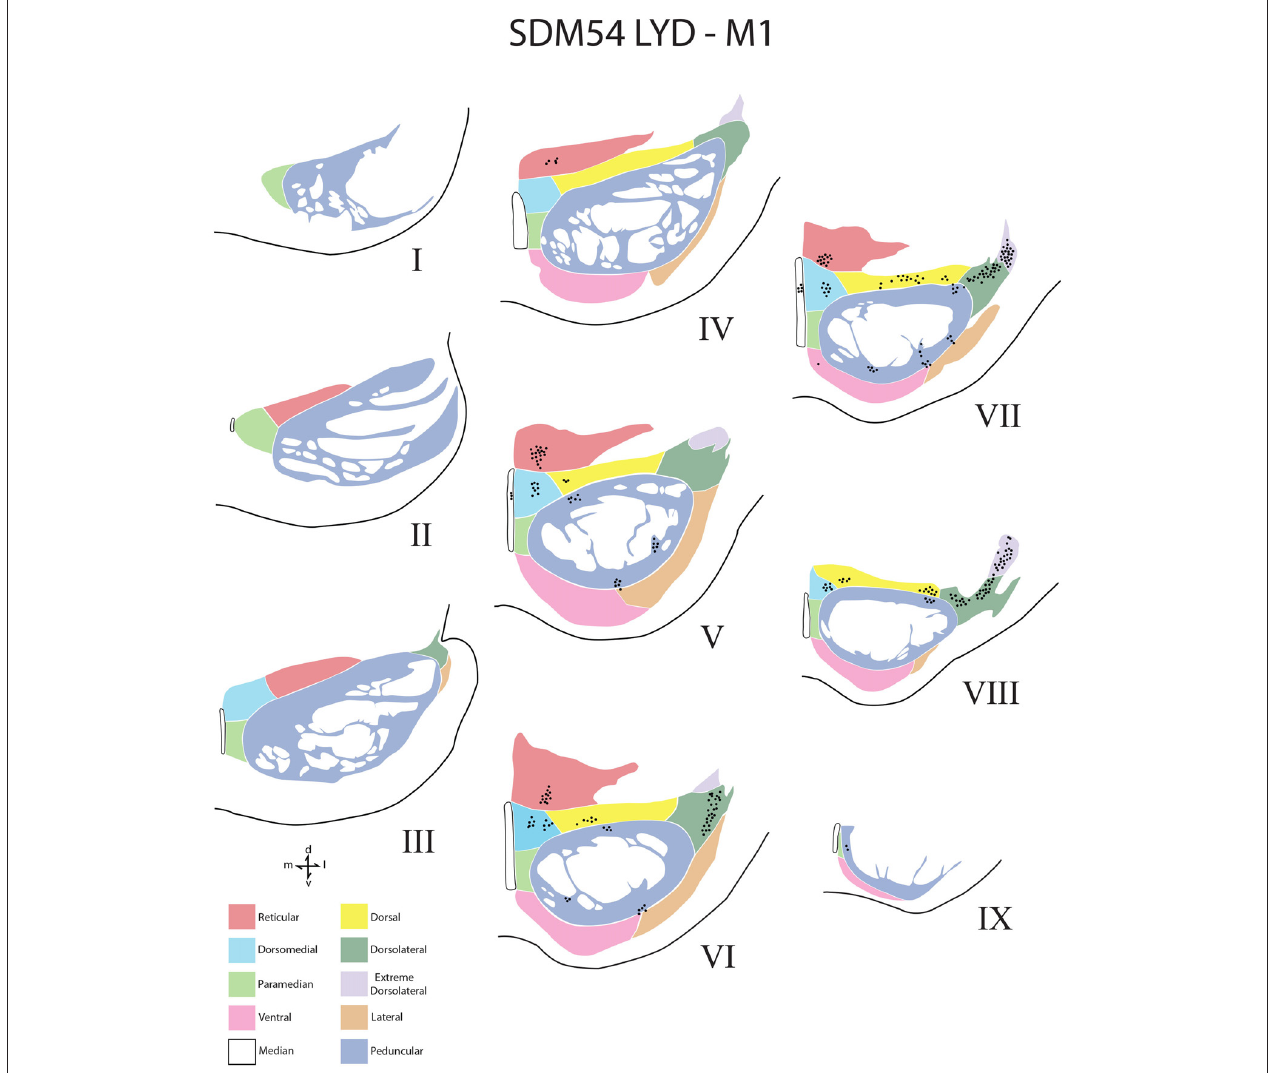
FIGURE 4 | Line drawings of transverse sections depicting the topographical distribution of labeled terminals (black dots) from superior (I) to inferior (IX) levels of the basis pontis in case SDM54 following an injection of LYD into the arm/hand region of M1. Note terminal labeling is primarily located in the dorsal region of the PN and at middle and inferior pontine levels. Each nucleus is identified by the color coded legend in the bottom left of the figure. The descending fibers of the longitudinal pontine fasciculus (LPF) are located in the central region of the peduncular nucleus. Abbreviations: d, dorsal; l, lateral; m, medial; v,